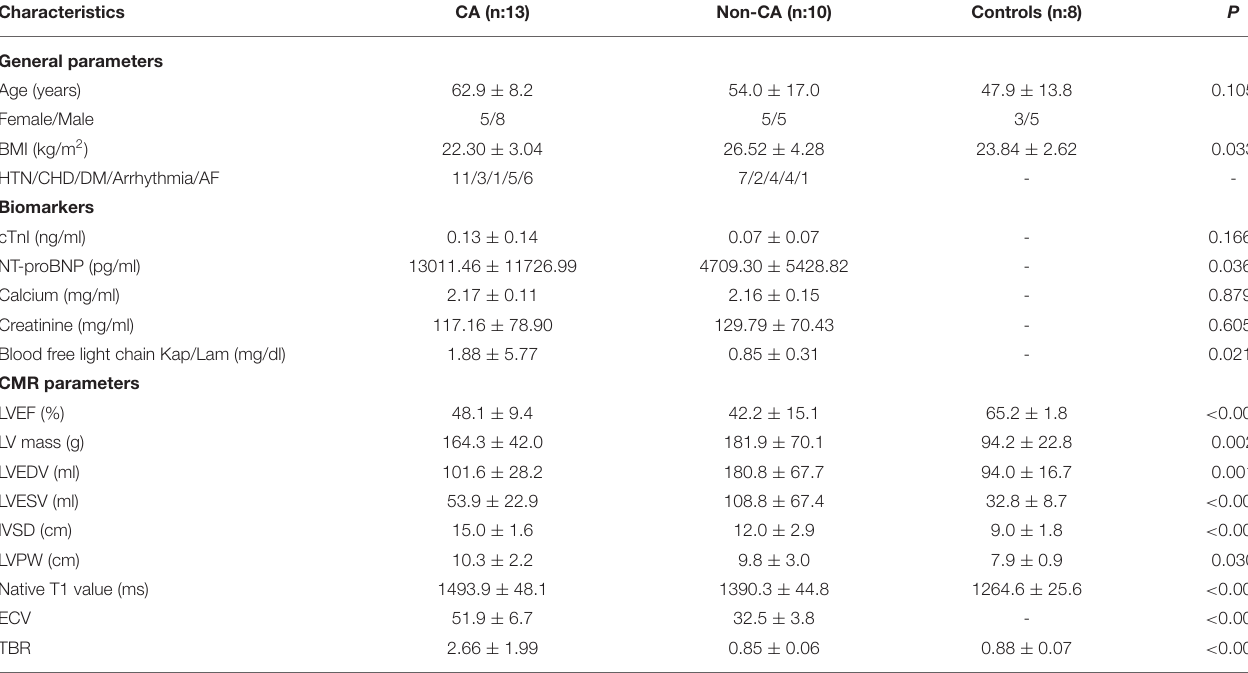
TABLE 2 | Baseline clinical characteristics of patients with cardiac amyloidosis (CA), those without CA (non-CA), and healthy control subjects. Characteristics